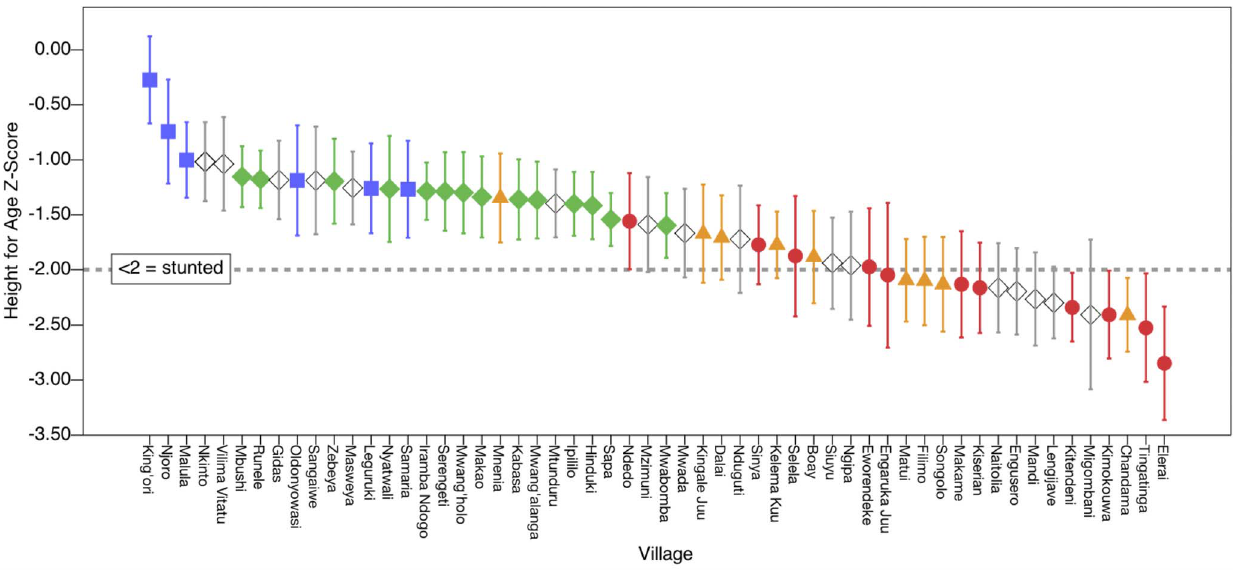
Figure2. Mean Height for Age Z-Score (HAZ) by Village and Ethnicity. Village means arranged in descending order, with 95% confidence intervals. Ethnicity is coded as the most common ethnicity in each village (see File S1 for details). Children in Maasai majority villages tend to have relatively low HAZ scores and children in Meru majority villages tend to have relatively high HAZ scores, with Sukuma and Rangi majority villages intermediate between these extremes. Red circle = Maasai village; orange triangle = Rangi village; green diamond = Sukuma village; blue square = Meru village; white diamond = Other ethnicity village. HAZ scores falling below , 2 are categorized as ‘‘stunted’’ by the World Health Organization.